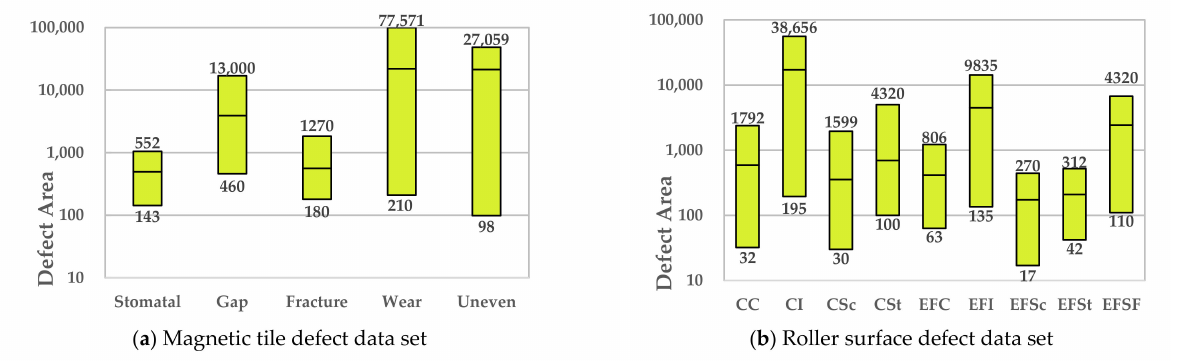
Figure 9. Defect area statistics of chart of different types of defect samples in the two data sets (The upper and lower lines of each column in the figure represent the maximum and minimum values respectively, and the middle line of each column represents the average